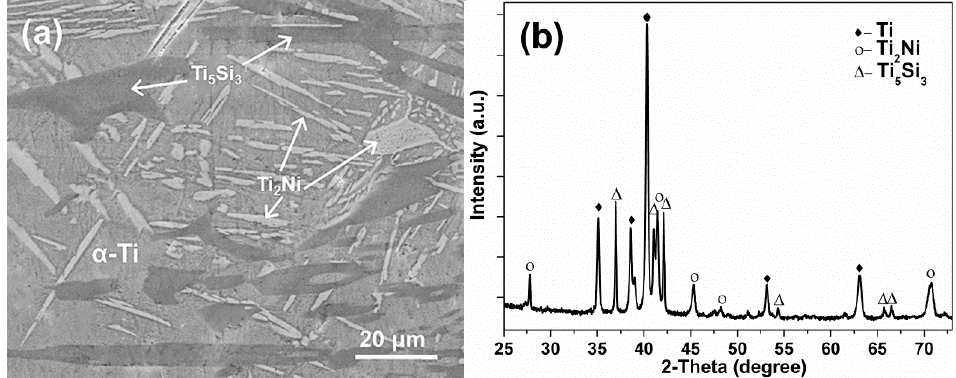
Figure 1. Schematic illustration of the anodization equipment.